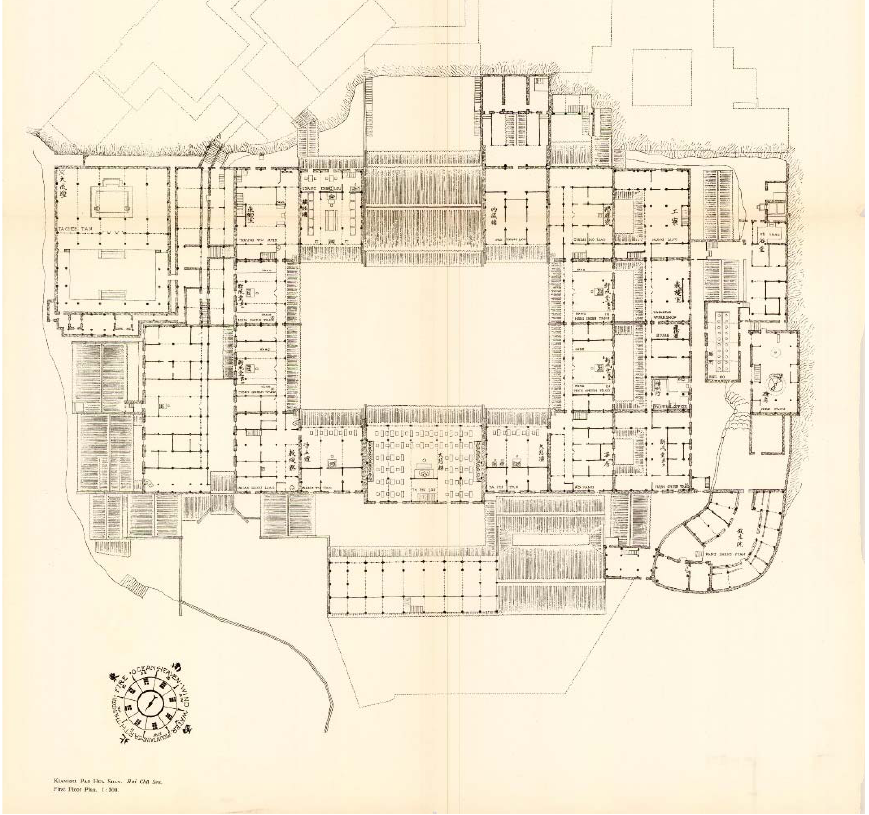
Figure 11. Second floor plan of Longchang Monastery (Prip ‐ Møller 1937, Pl. 2).